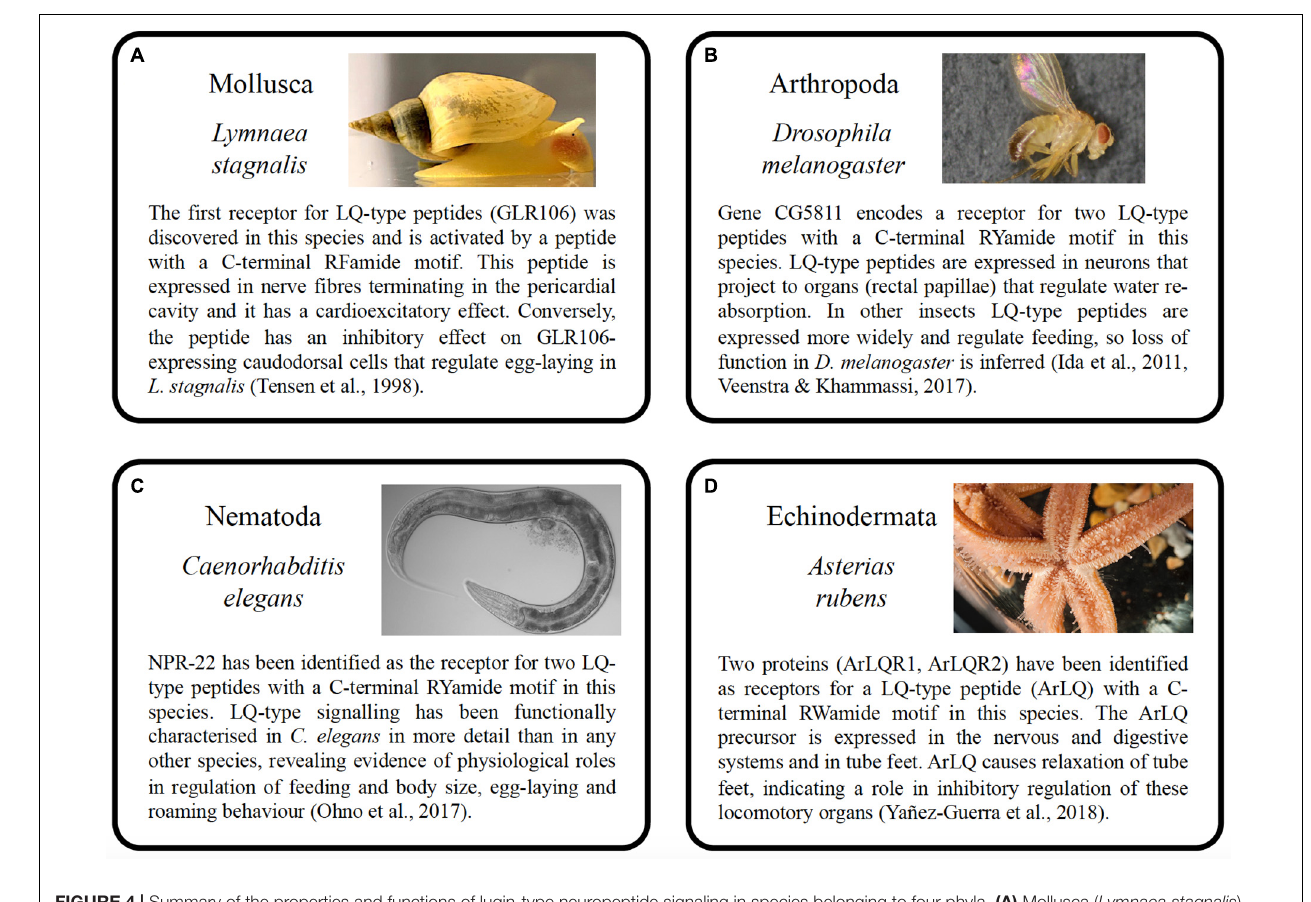
FIGURE 4 | Summary of the properties and functions of luqin-type neuropeptide signaling in species belonging to four phyla. (A) Mollusca ( Lymnaea stagnalis ), (B) Arthropoda ( Drosophila melanogaster ), (C) Nematoda ( Caenorhabditis elegans ), and (D) Echinodermata ( Asterias rubens ). The photographs of the animals shown in A – D were taken by Michael Crossley (University of Sussex, United Kingdom), Marycruz Flores-Flores (Centro de Investigación y de Estudios Avanzados del Instituto Politécnico Nacional, Mexico), Marina Ezcurra (University of Kent, United Kingdom), and Ray Crundwell (Queen Mary University of London, United